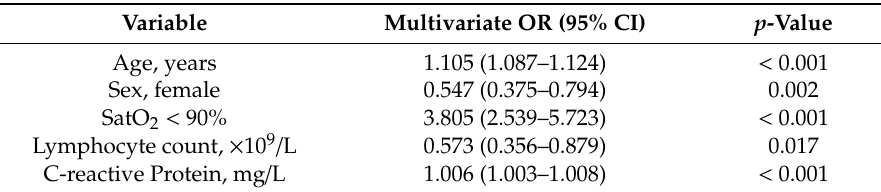
Table 5. Risk factors associated with in-hospital